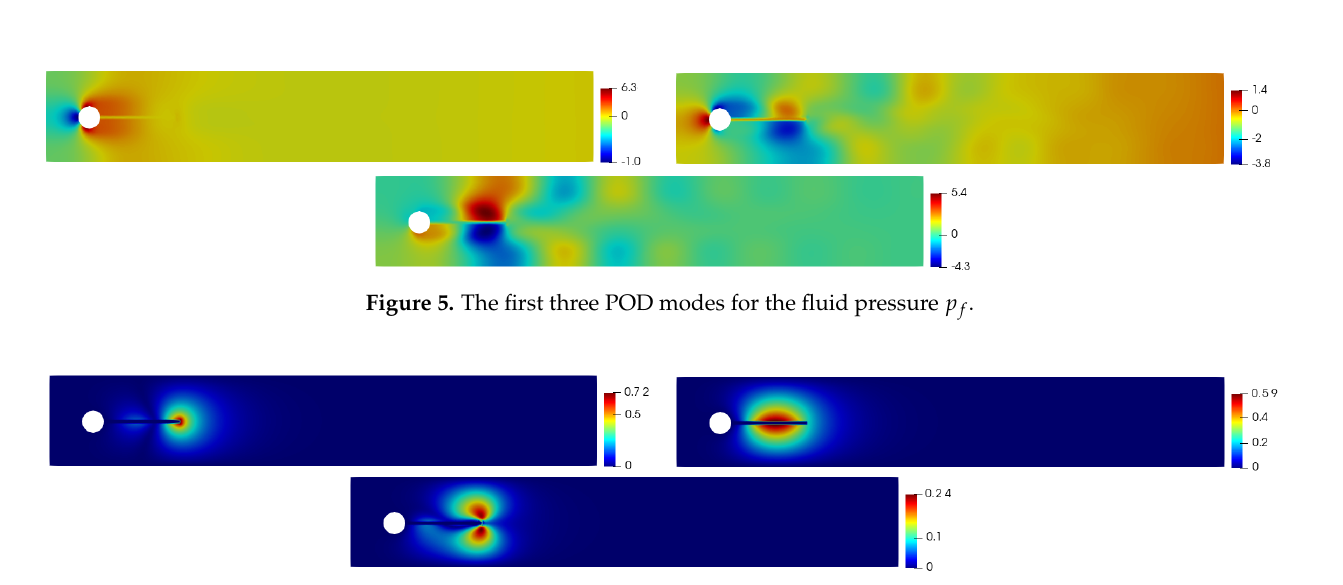
Figure 6. The first three POD modes for the fluid displacement d f (magnitude).